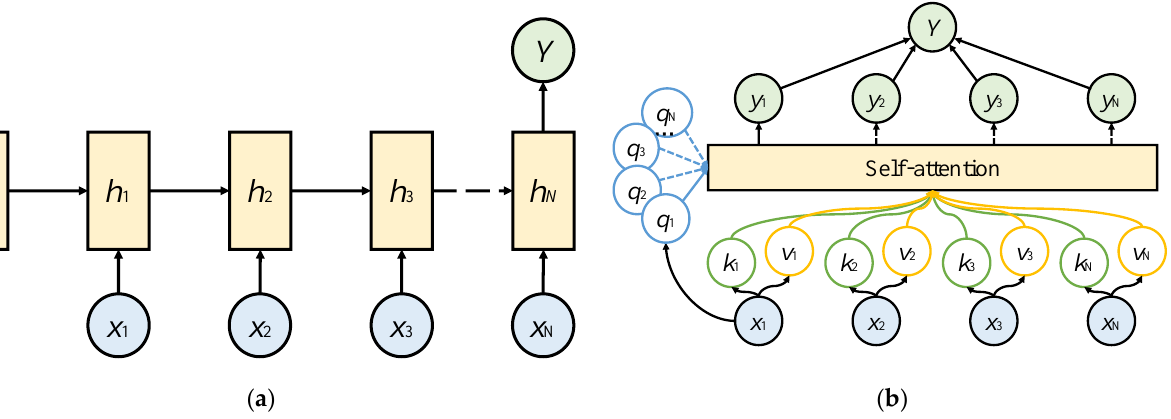
Figure 3. Neural network structures: ( a ) recurrent neural network structure; ( b ) self-attention network structure.